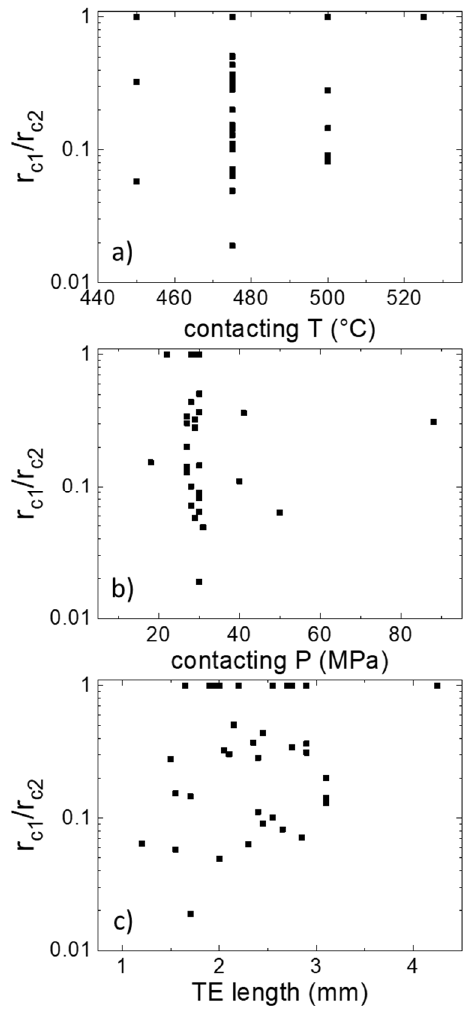
Figure 1. Ratio of the two electrical contact resistances of the same sample (smaller/larger) depending on various experimental parameters: ( a ) contacting temperature, ( b ) contacting pressure, ( c ) TE length before contacting. The samples are all Mg 2 (Si,Sn) with Al electrodes.